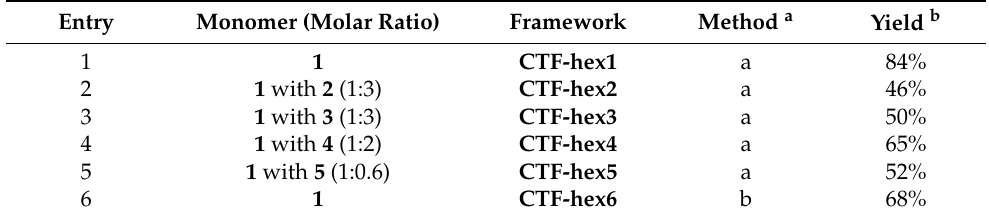
Table 1. Monomers and ratio, synthesis method and yields for triazine-based frameworks CTF-hex1 – 6 . Entry Monomer (Molar Ratio) Framework Method a Yield